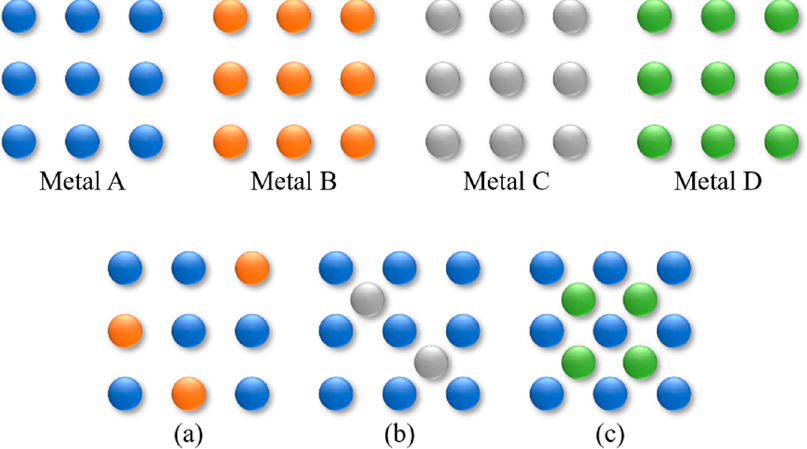
Figure 1. Bimetallic alloy structures: ( a ) substitutional and ( b ) interstitial solid-solution alloys and ( c ) intermetallic compounds.